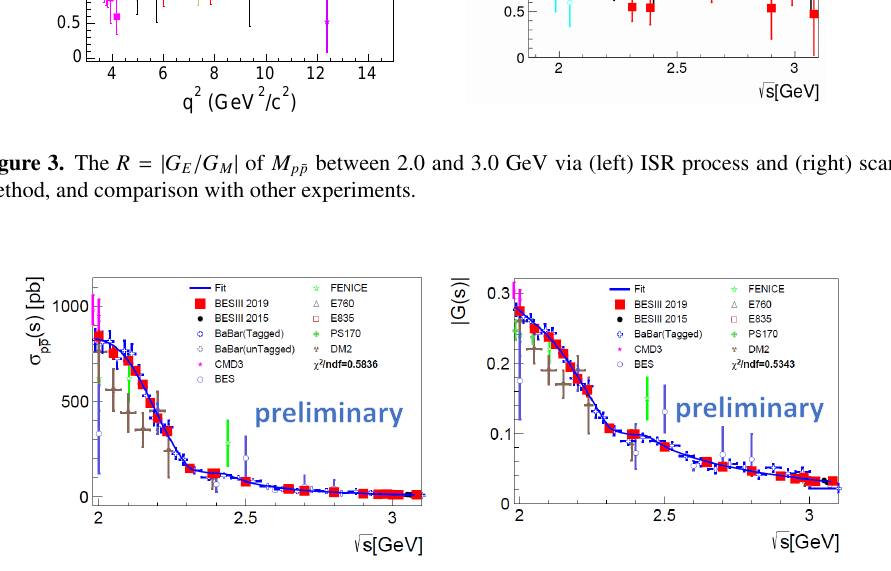
Figure 4. The measured (left) cross sections and (right) form factors via scan method